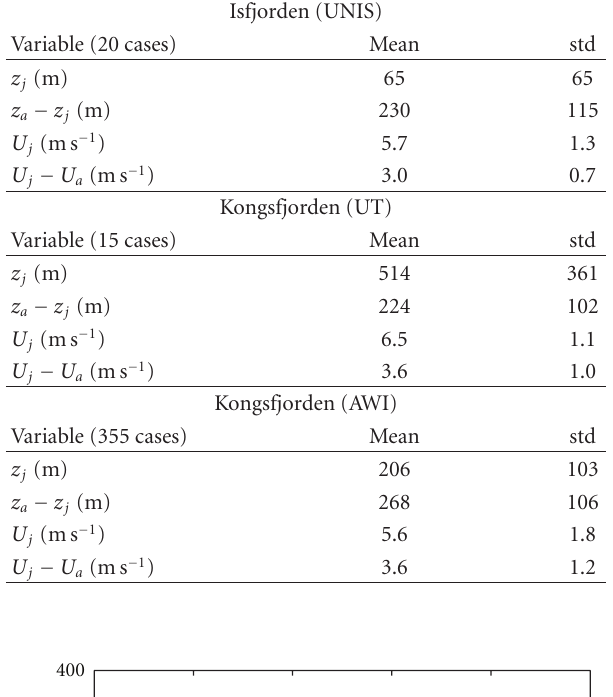
Figure 9: A schematic presentation of katabatic flows over (a) ice- free Isfjorden and (b) ice-covered Kongsfjorden. H and LE denote the turbulent fluxes of sensible and latent heat,